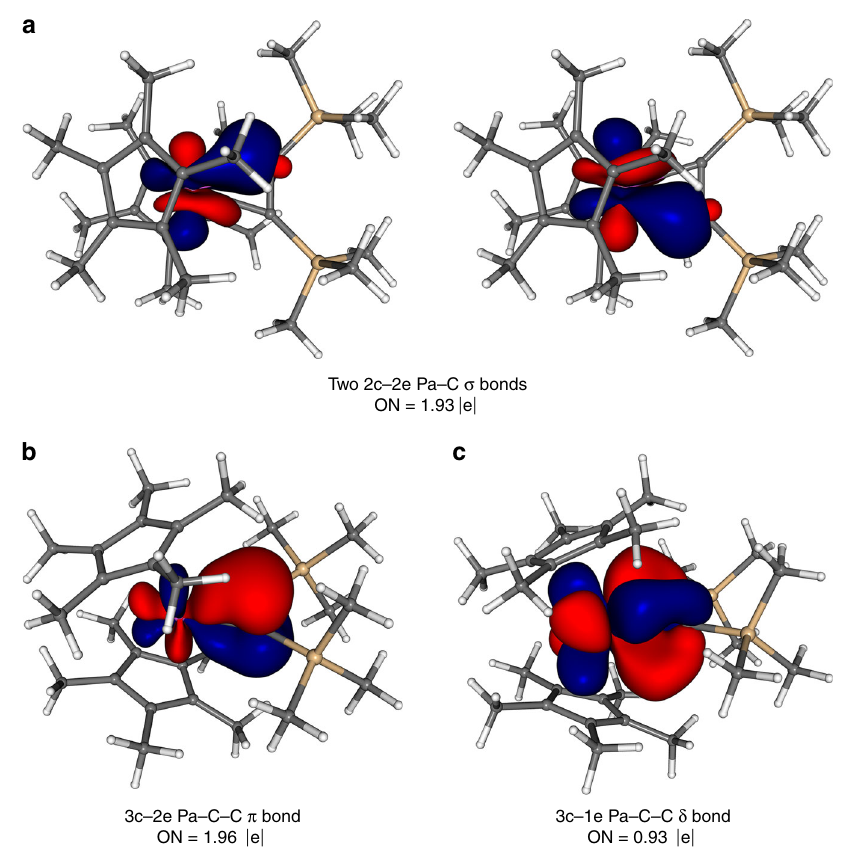
Fig. 5 AdNDP bonding elements found between the C 2 (SiMe 3 ) 2 ligand and the M center in the example of Pa-propene complex. a Two direct Pa – C σ bonds (left and right). b Three-center Pa – C – C π bond. c Singly occupied three-center Pa – C – C δ bond. Sticks between atoms help visualization and do not necessarily represent classical 2c – 2e bonds here and elsewhere. ON is equal to 2.00|e| or 1.00|e| in an ideal case for a doubly or singly occupied bond,